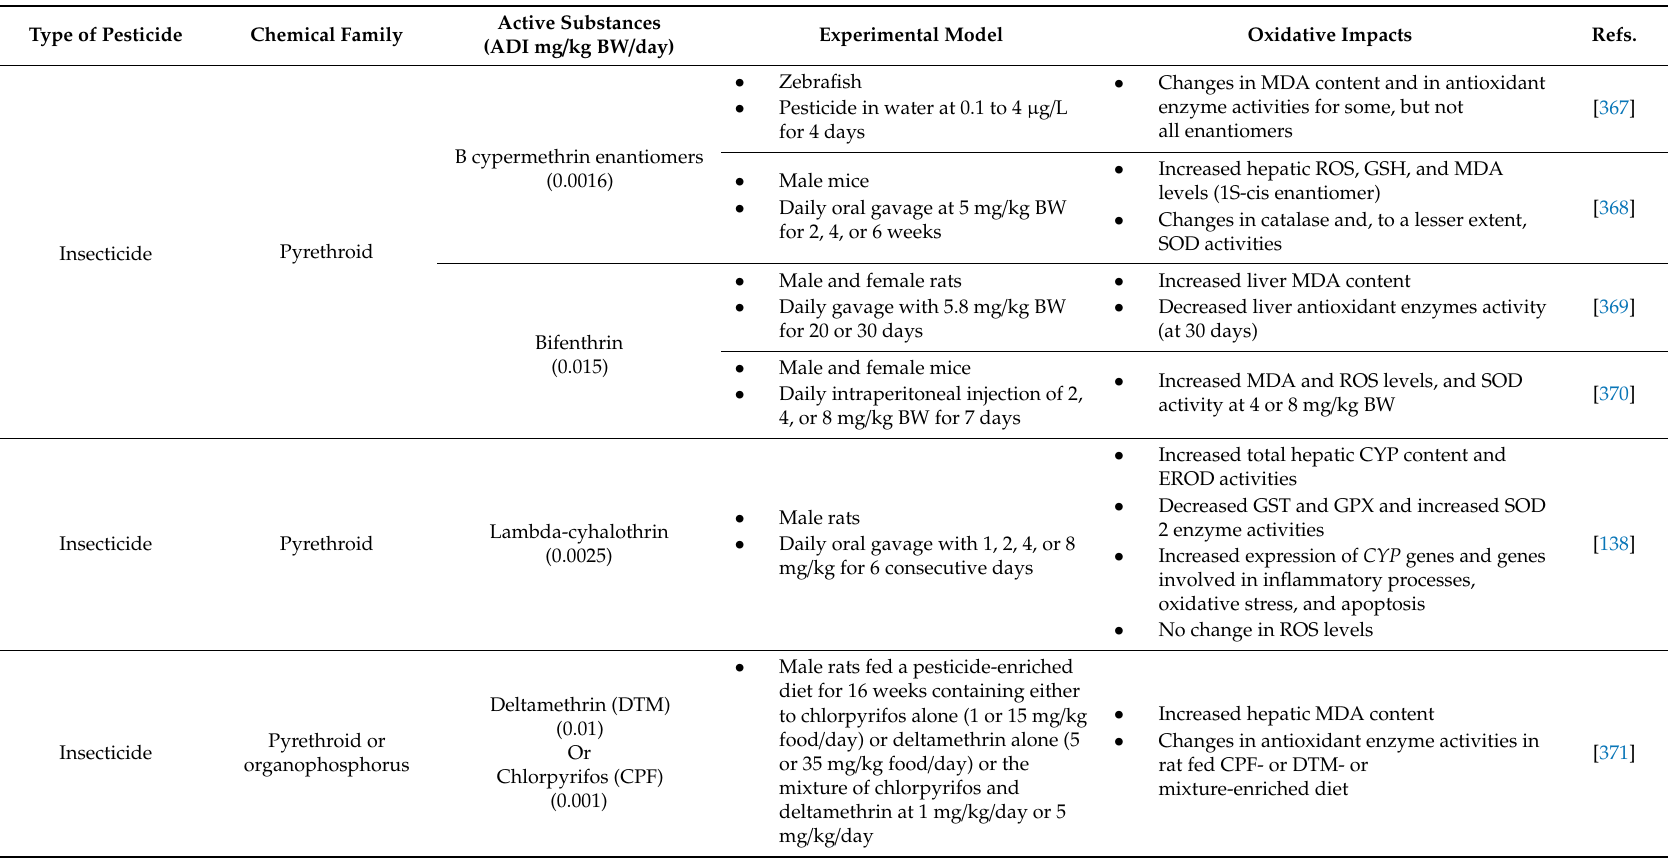
Table 3. Impact of pesticide exposure on oxidative stats in in vivo models. Acceptable Daily Intake (ADI) values were from https: // ephy.anses.fr / and https: // ec.europa.eu / food / plant / pesticides / eu-pesticides-database / . ALT, alanine aminotransferase; AST, aspartate aminotransferase; BW, body weight; CYP, cytochrome P450; EROD, ethoxyresorufin-O-deethylase; MDA, malondialdehyde; GPX, glutathione peroxidase; GSH, reduced glutathione; GSSG, oxidized